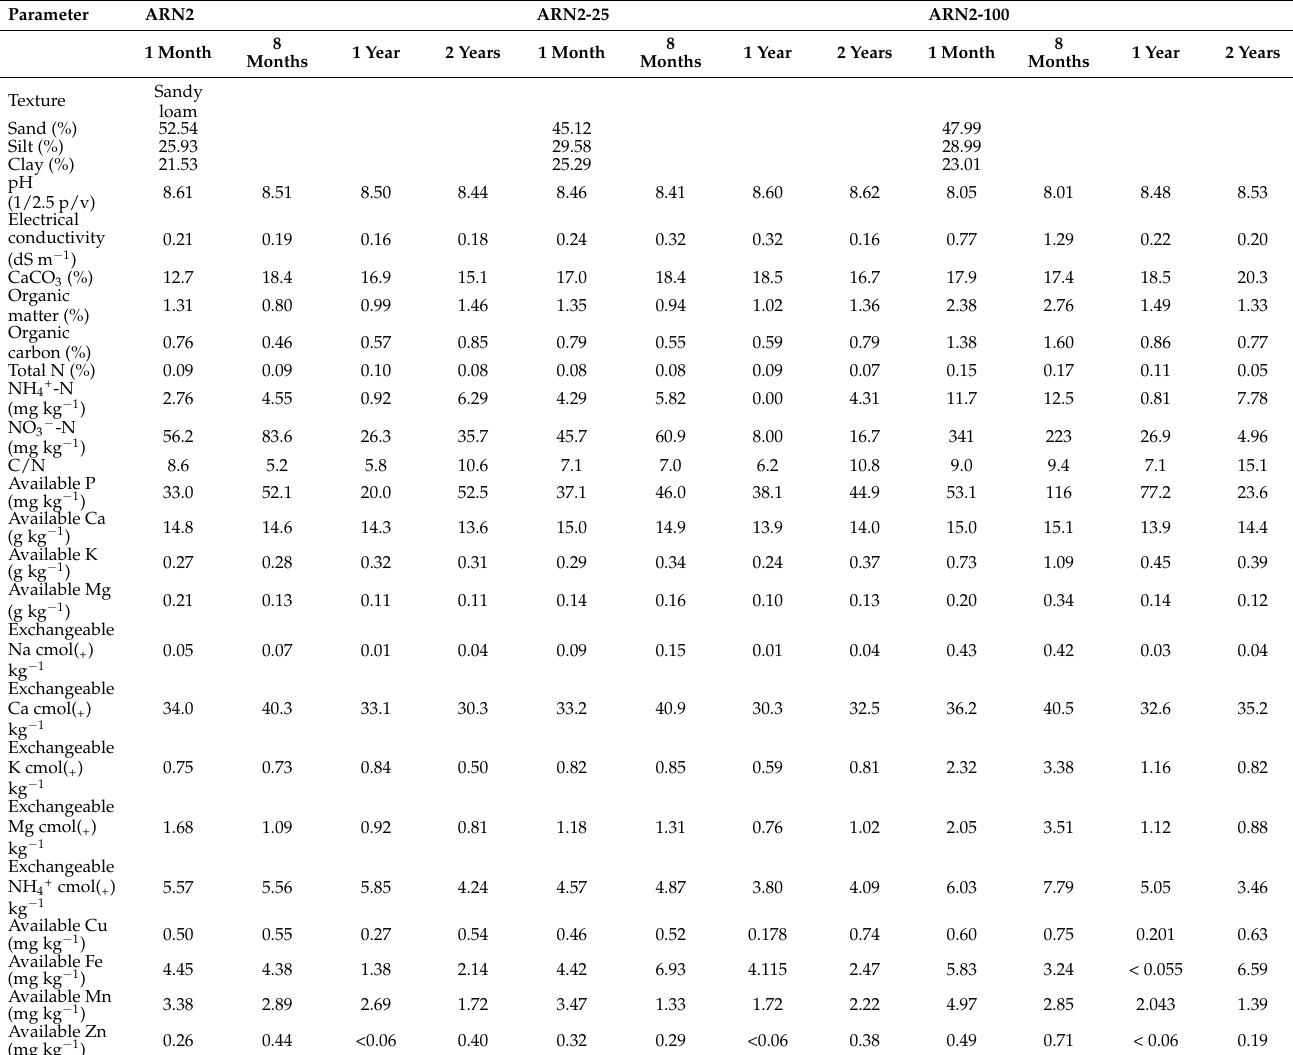
Table 3. Characteristics of unamended soil (ARN2) and of soil amended with SMS at two doses (ARN2-25 and ARN2-100) over the experimental